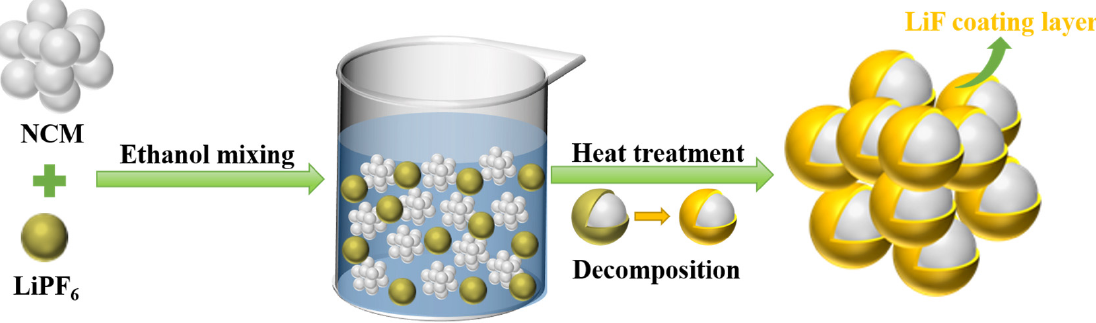
Figure 1. Schematic diagram of the decomposition of LiPF 6 and the formation of LiF on NCM par- ticles.